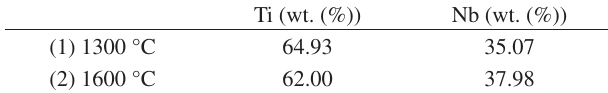
Table 2. Ti and Nb contents in α and β areas analyzed in the Figure 2